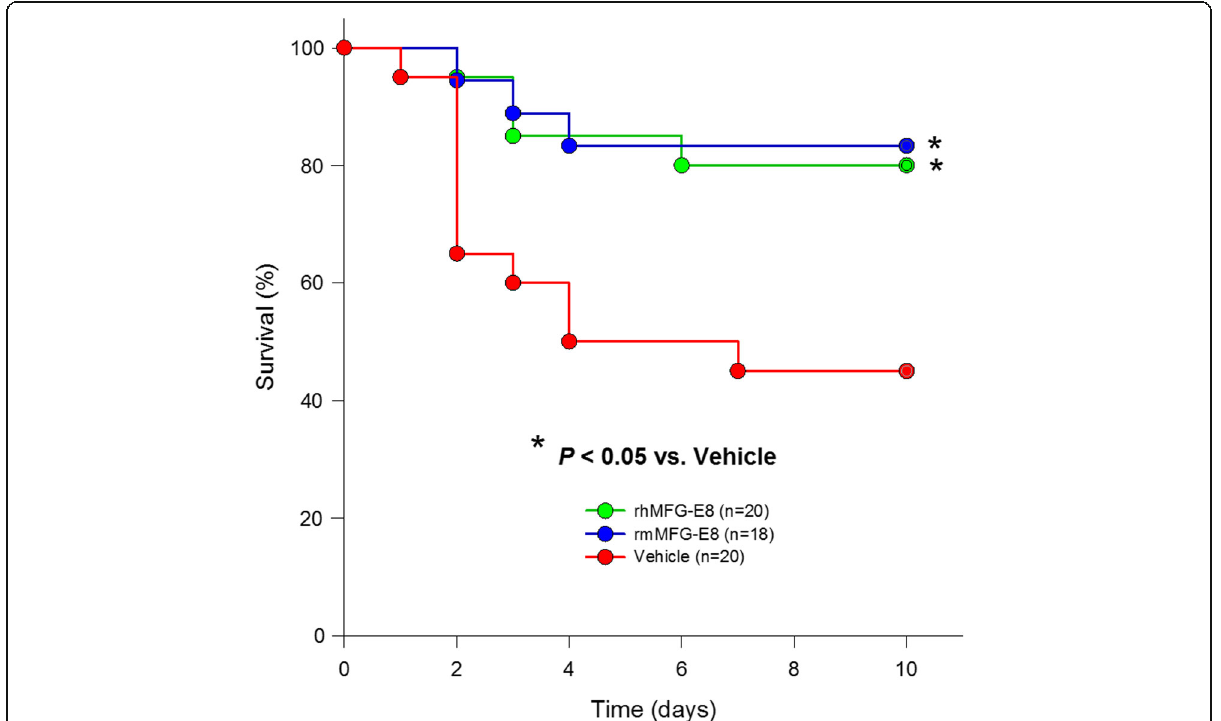
Fig. 6 rhMFG-E8 improves the survival rate in CLP after acute alcohol exposure. The 10-day survival rate of rats subjected to CLP and treated with 20 μ /kg BW rhMFG-E8 was significantly higher than that of rats subjected to CLP and treated with vehicle (20 μ /kg BW human albumin). The survival benefit of animals treated with rhMFG-E8 was similar to that of animals treated with 20 μ /kg BW rmMFG-E8. Prior to CLP, all rats were exposed to acute alcohol intoxication; CLP was attenuated by surgical excision of the gangrenous cecum and peritoneal cavity irrigation at 20 h after CLP; n = 18 for rhMFG-E8 and n = 20 for other experimental groups); Kaplan-Meier plus log-rank test, * P < 0.05 vs.